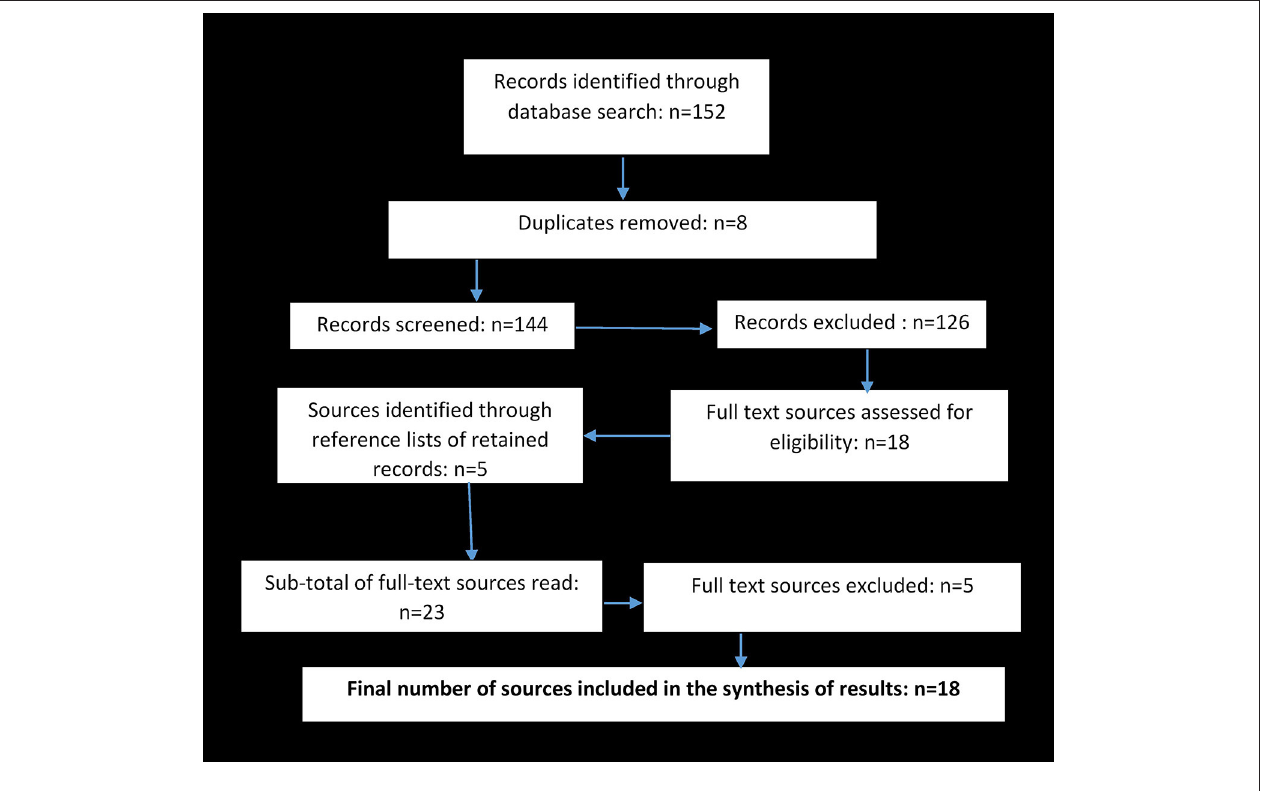
FIGURE 1 | Records searched and sources